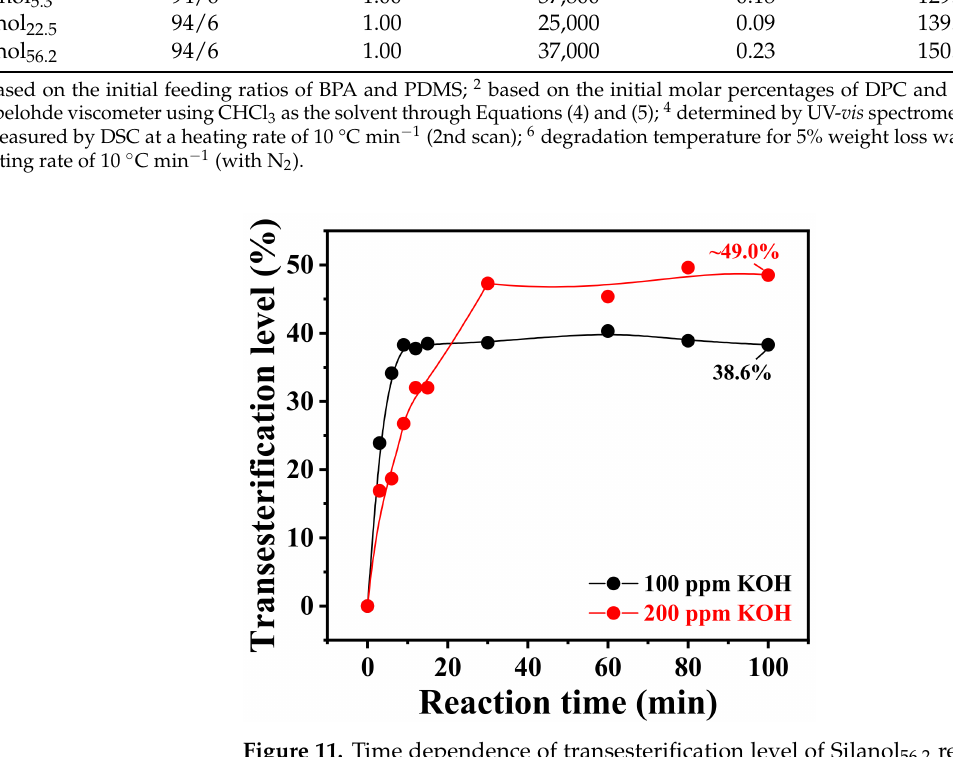
Figure 11. Time dependence of transesterification level of Silanol 56.2 reacted with DPC under the catalysis of different amounts of KOH at 180 ◦ C. Table 7. Molecular-structure characteristics of PC-PDMS copolymers prepared by different amounts of KOH obtained from 1 H-NMR and 13